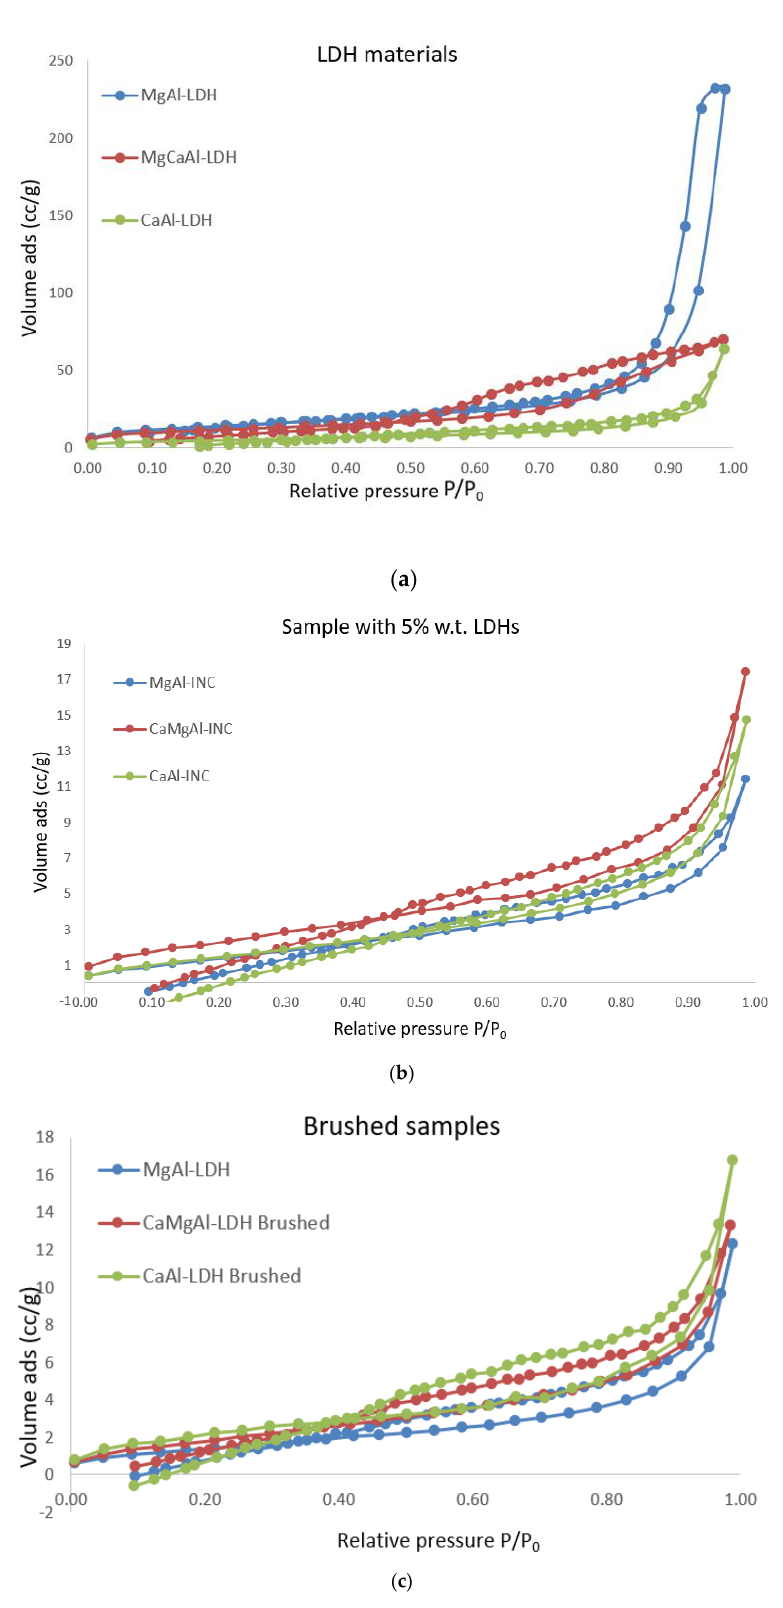
Figure 5. Nitrogen adsorption isotherms for LDH consolidants and treated materials ( a ) LDH ma- terials; ( b )samples with 5% wt LDH; ( c ) brushed